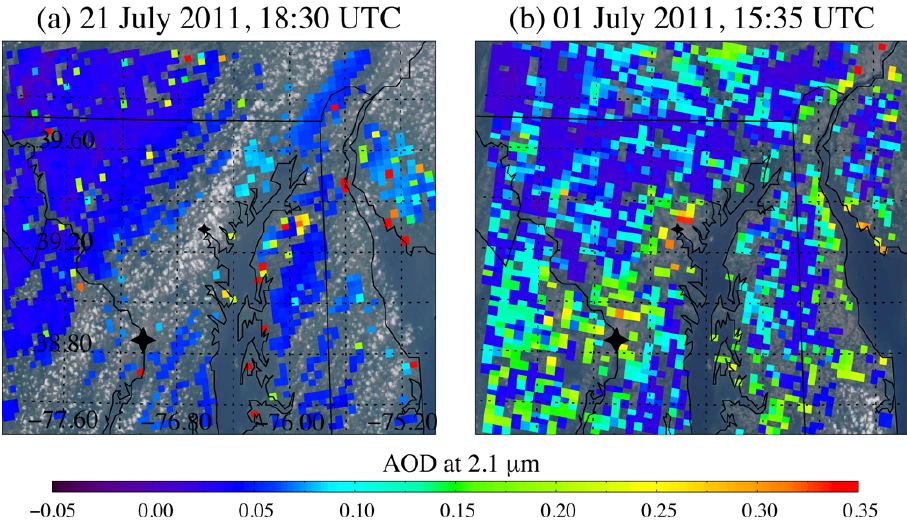
Fig. 10. (a) 3km AOD at 2.1µm observed by MODIS-Aqua on 21 July 2011 at 18:30UTC. (b) 3km AOD at 2.1µm observed by MODIS- Terra on 1 July 2011 at 15:35UTC. Only land pixels with a QA=3 are shown. Washington D.C. is shown with the large black star and Baltimore is shown with the small black star. The true color image, created from the MODIS red, green and blue bands, is shown in the